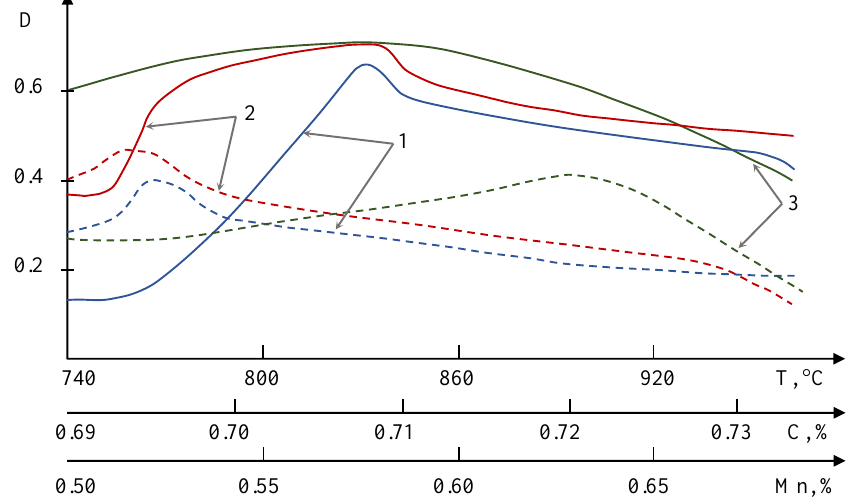
Figure 5. Sensitivity of the generalized criterion to the variation in factors: 1— D ( T ) , 2— D ( C ) , 3— D ( Mn ) . (Solid lines—in the vicinity of the optimum; dashed—in the vicinity of the center of the experiment